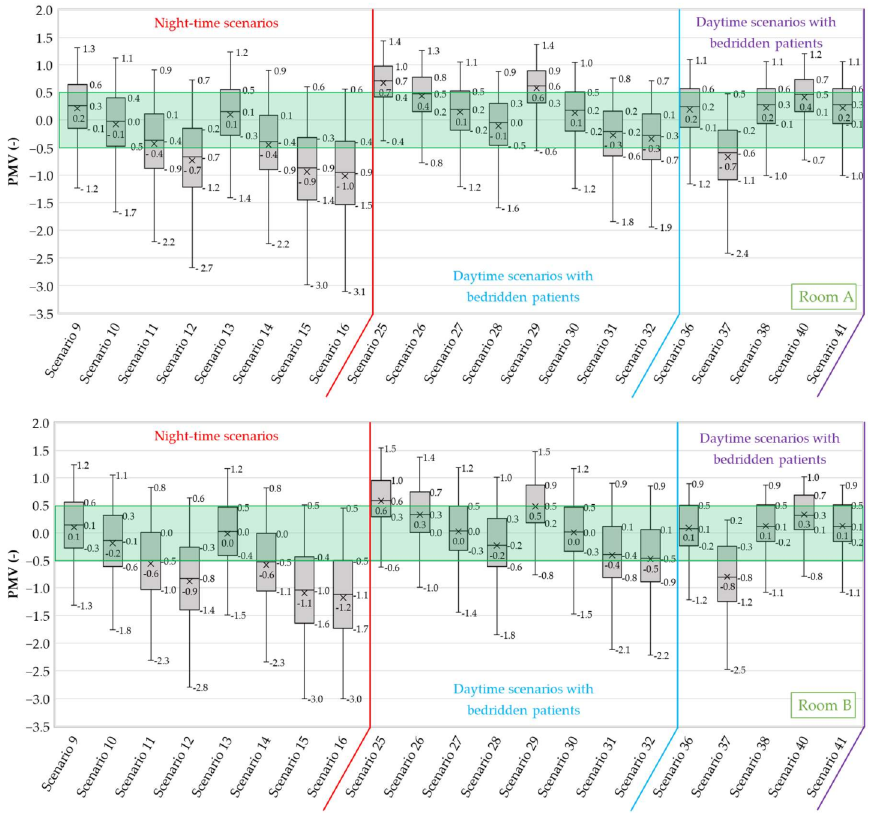
Figure 21. PMV distributions of the different scenarios in spring